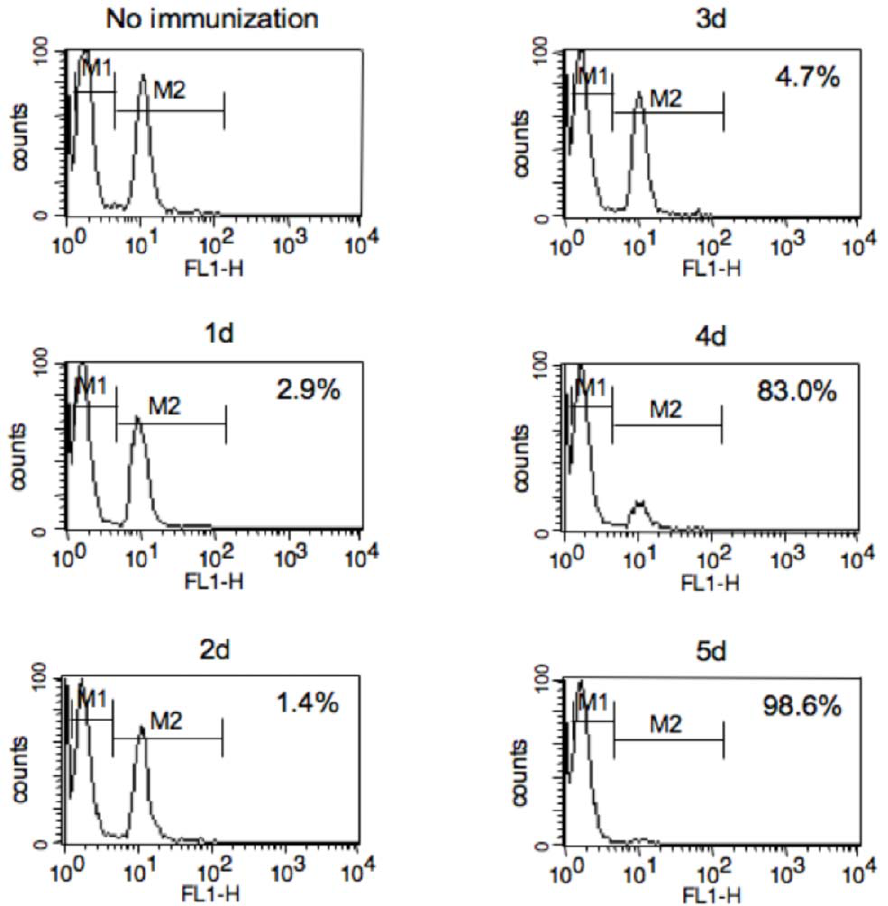
Figure 1. Kinetics of primary CTL response induced by OVA 257-264 -liposome conjugates. Mice were immunized with 50 m l of OVA 257-264 - liposome in the presence of 5 m g CpG; one to 5 days later, an in vivo CTL assay was performed as described in Materials and Methods. The numbers for each time period indicate percentages of target cells killed. Data are representative of three individual mice in each group for which similar results were obtained.